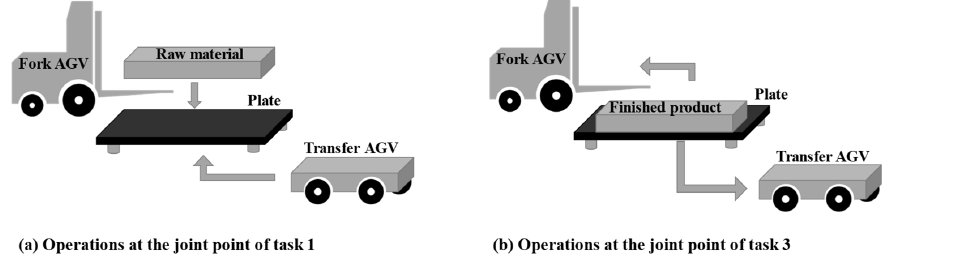
Fig. 2. The operations at the joint point